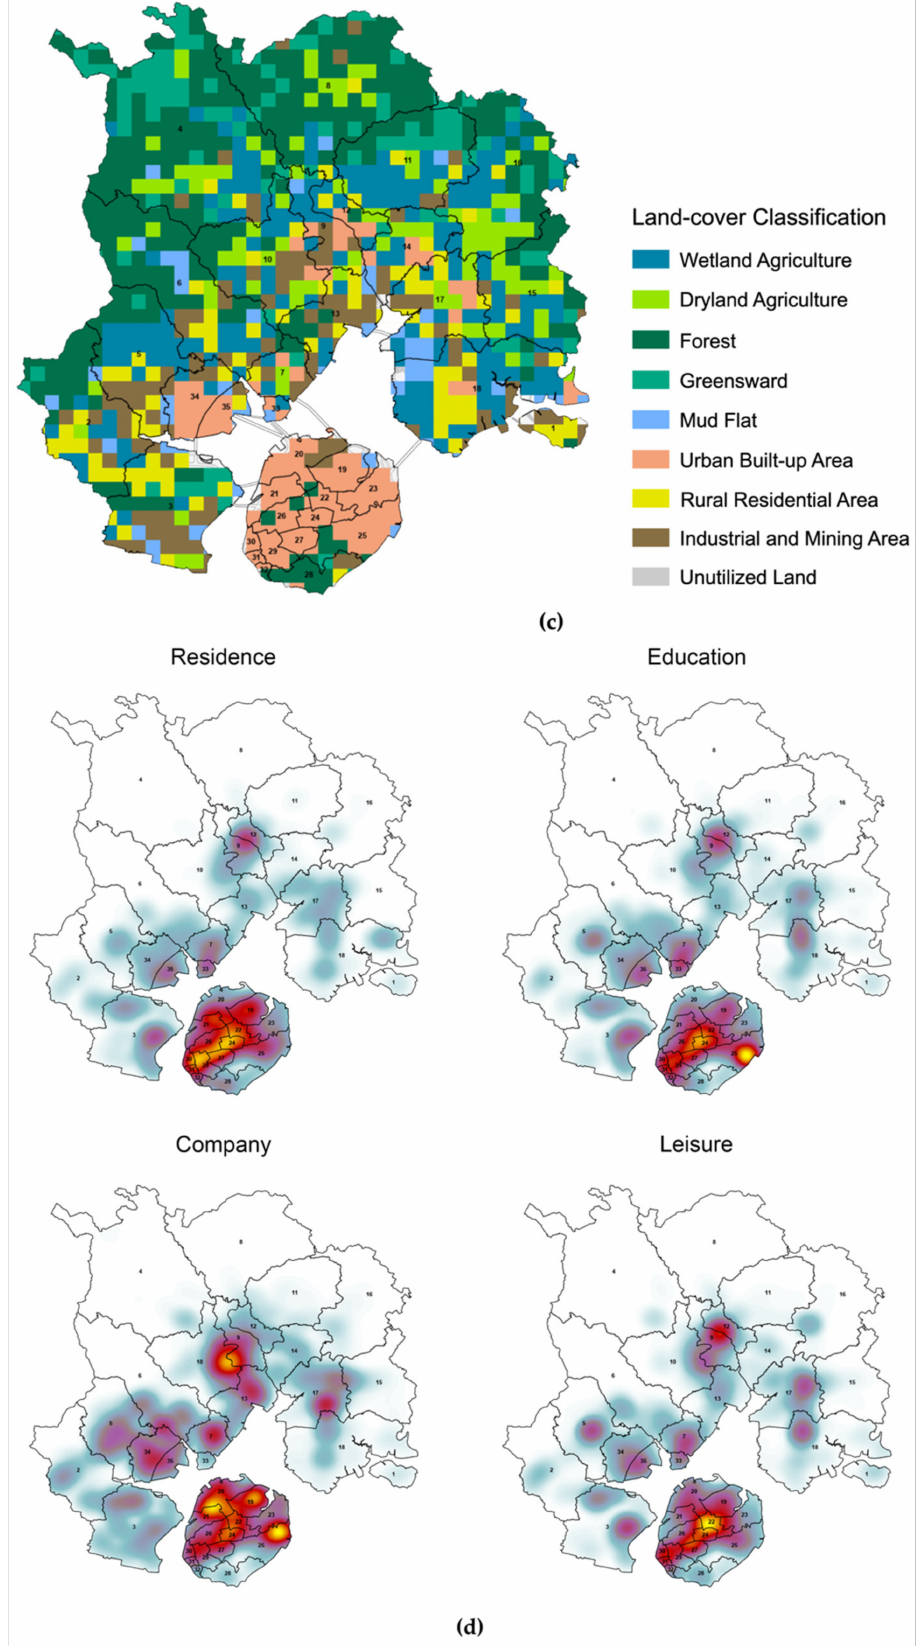
Figure 1. Basic information about Xiamen: ( a ) location and administrative boundary; ( b ) ID and population density of each town (persons/km 2 ); ( c ) land-cover classification in 1-km resolution; and ( d ) heat map (relative density) of points of